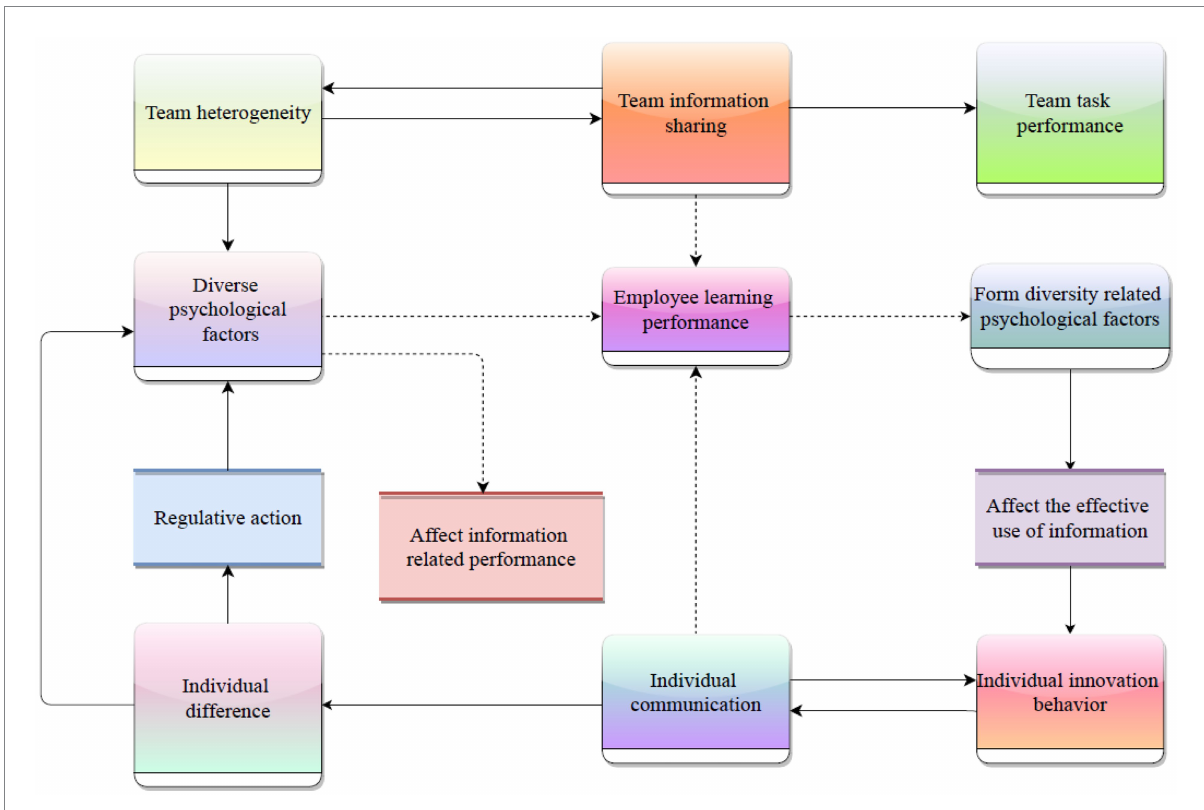
FIGURE 1 Based on the conceptual model of the relationship between characteristic emotional psychological factors and information-related